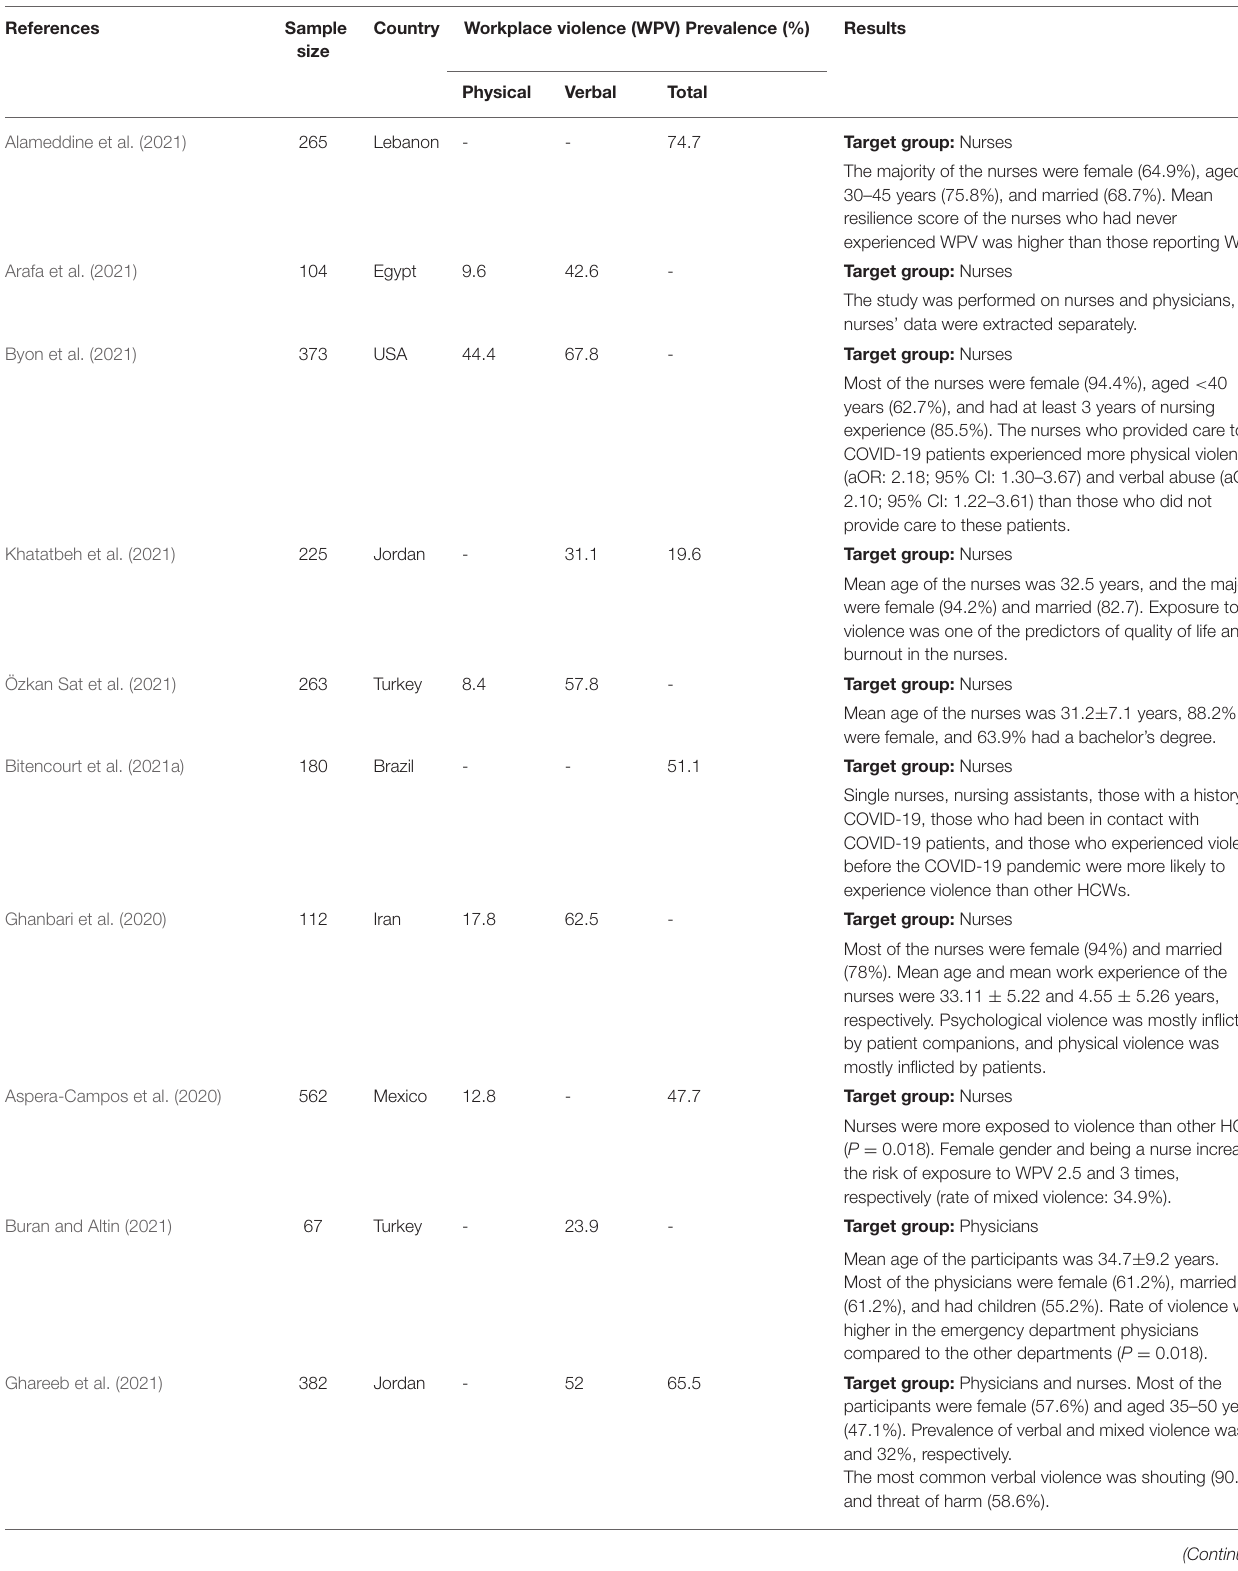
TABLE 1 | Characteristics of reviewed